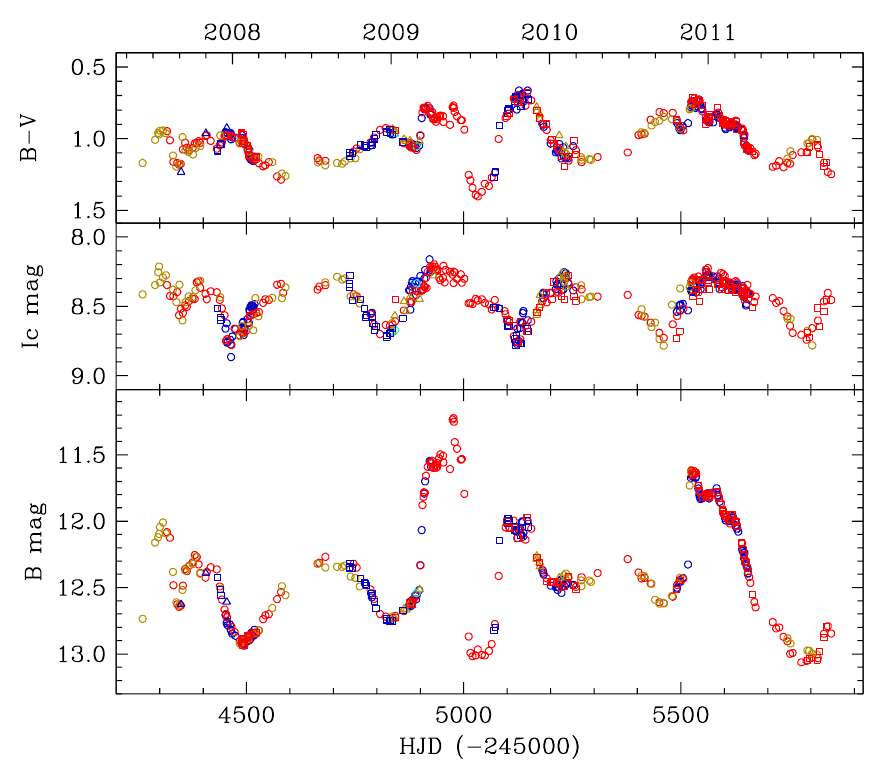
Fig. 5. The recent light curve of the classical symbiotic star AX Per. Different symbols and colors identify data from different ANS